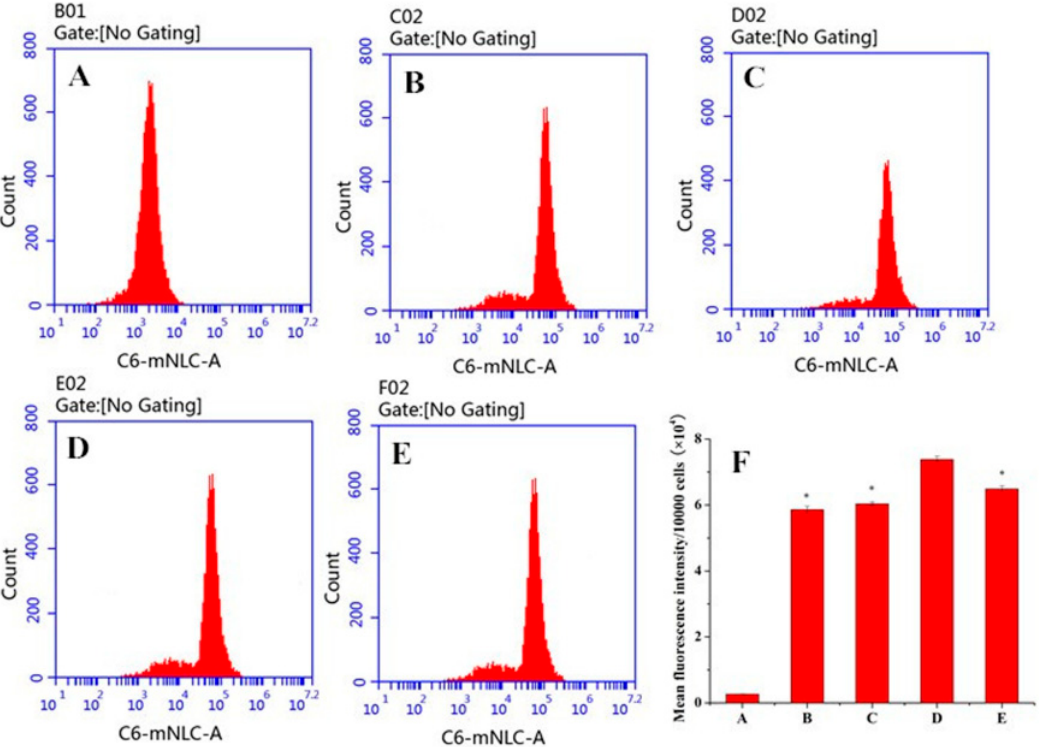
Figure 8. Flow cytometry analysis. ( A ) negative control group (blank culture medium without NLCs);